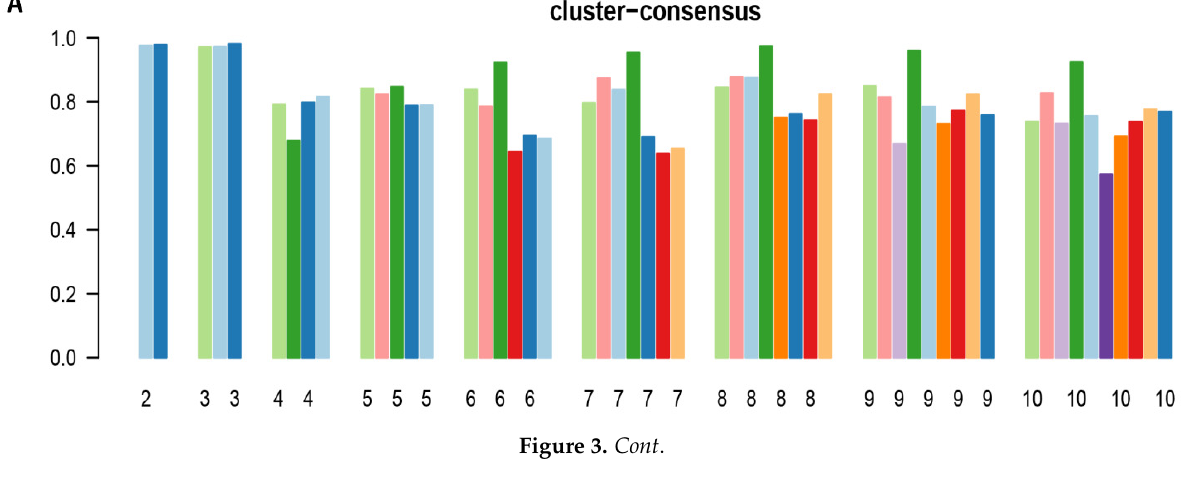
Figure 3. ( A ) The bar plot represents the mean consensus score for different numbers of clusters (K ranges from two to ten) for patients with hypomagnesemia; ( B ) The bar plot represents the mean consensus score for different numbers of clusters (K ranges from two to ten) for patients with hypermagnesemia. Cluster 1 had 3446 (26%) patients. Cluster 2 had 4351 (33%) patients. Cluster 3 had 5523 (41%) patients. As shown in Table 1, baseline characteristics significantly differed among the three clusters in the hypomagnesemia cohort.